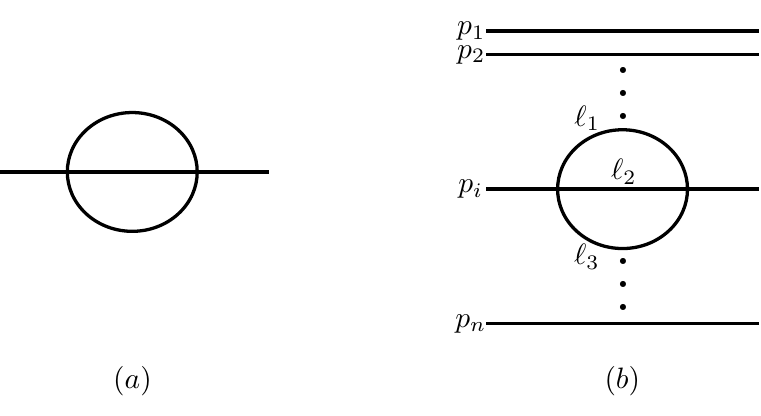
Figure 1 . (a) Sunset diagram; (b) Sunset diagram with